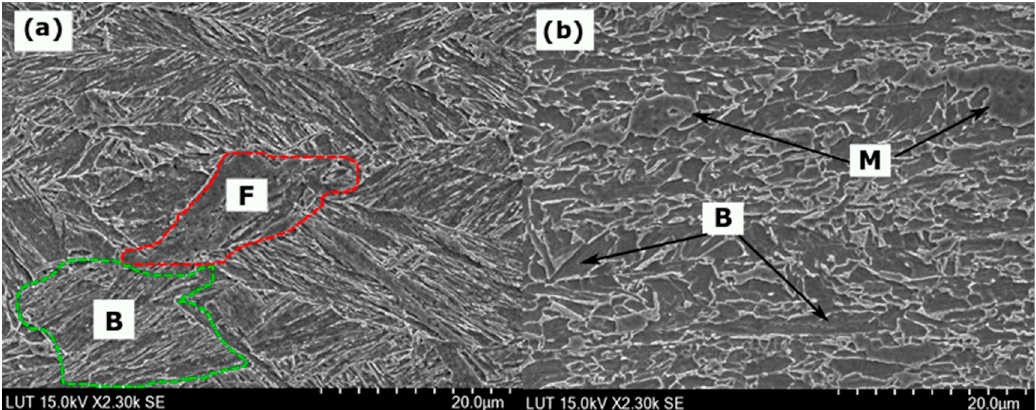
Figure 7. SEM micrographs of the base materials: ( a ) S700MC and ( b ) S960QC high-strength steels.